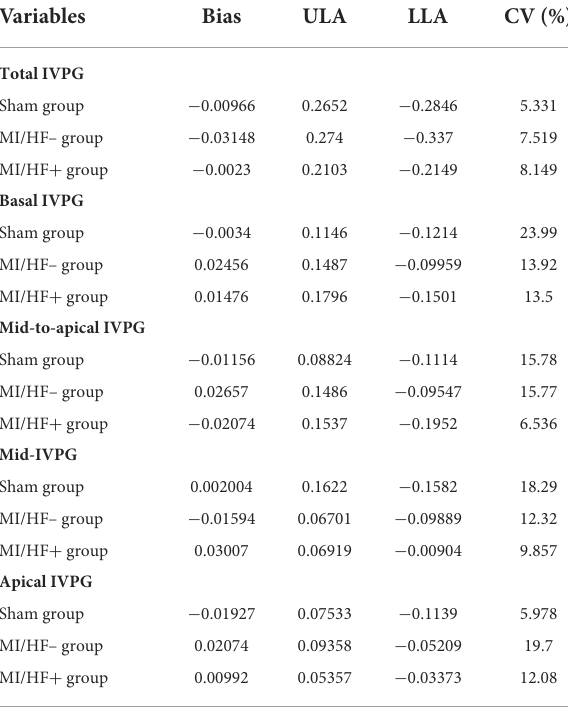
TABLE 7 Intra-observer reproducibility of the IVPG